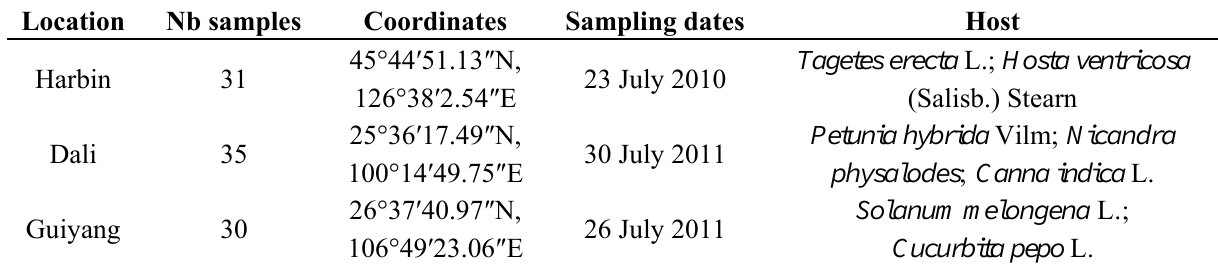
Table 3. Collection information for samples used in this study.